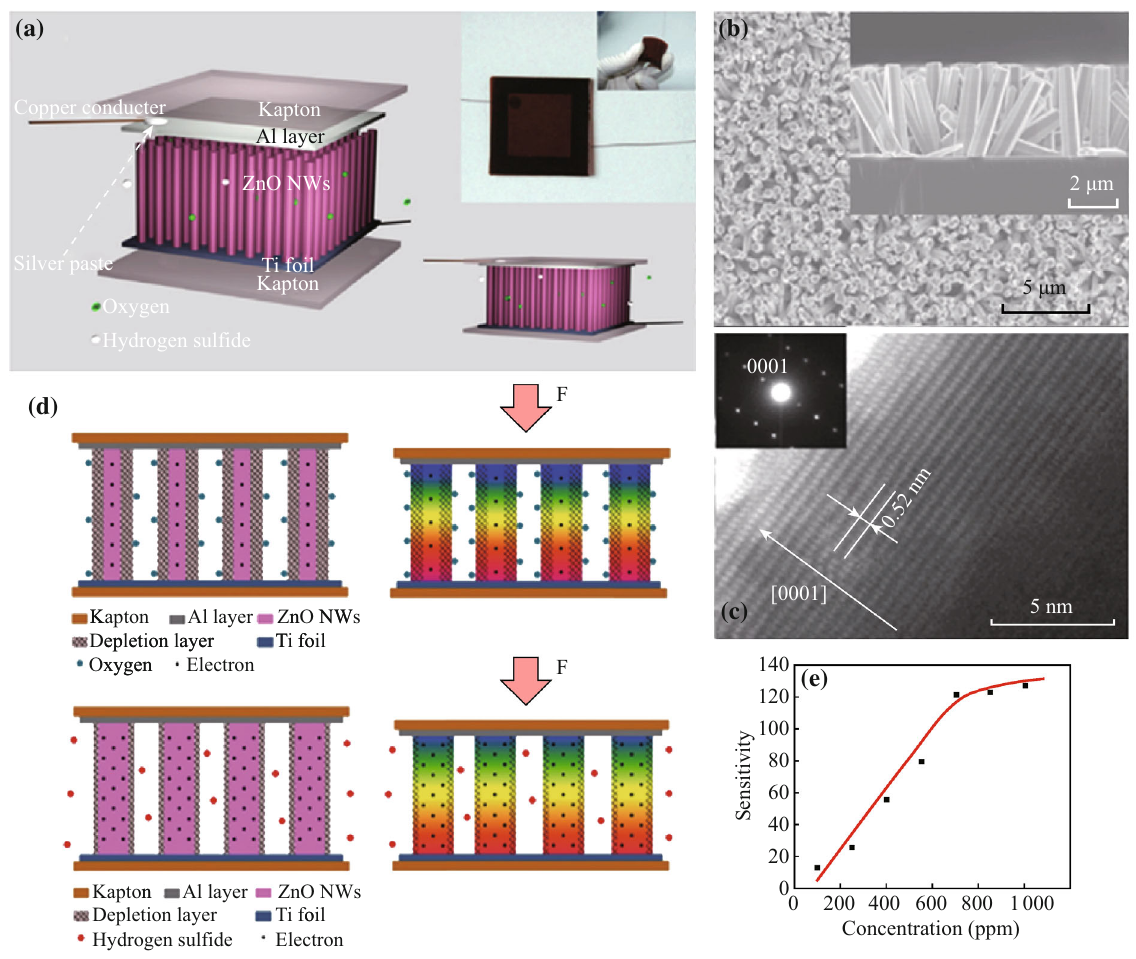
Fig. 2 Surface free-carrier screening effect on the output of a ZnO NW-based PENG and its potential as a self-powered active gas sensor. a Schematic diagram showing the structural design of the PENG (the inset is a photograph of a typical device). b SEM image of ZnO NW arrays grown on Ti foil in a top view (the inset shows SEM the cross-sectional view image). c HRTEM and SAED pattern taken from the tip region of a ZnO NW. d The working mechanism of the PENG was driven by compressive strain. e The dependence of sensitivity on the ranging concentrations of H 2 S vapor. Figures adapted from